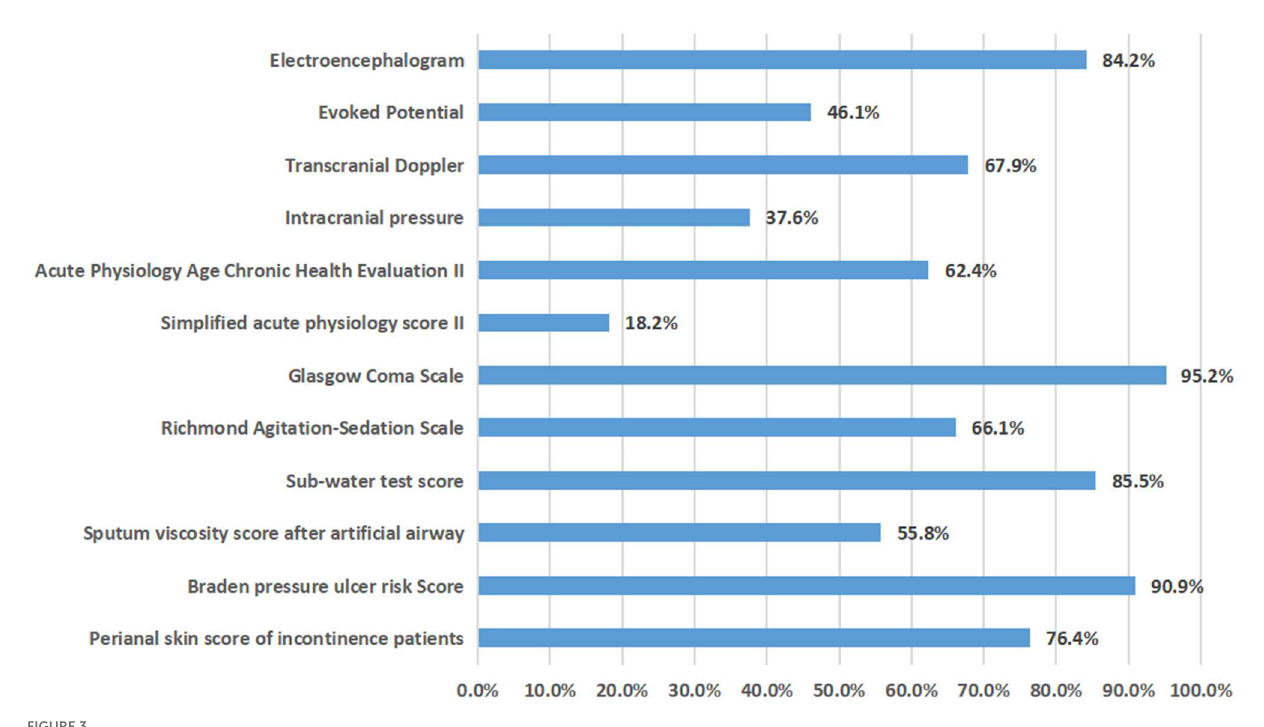
FIGURE3 Proportion of 165 NCCU evaluation technologies in